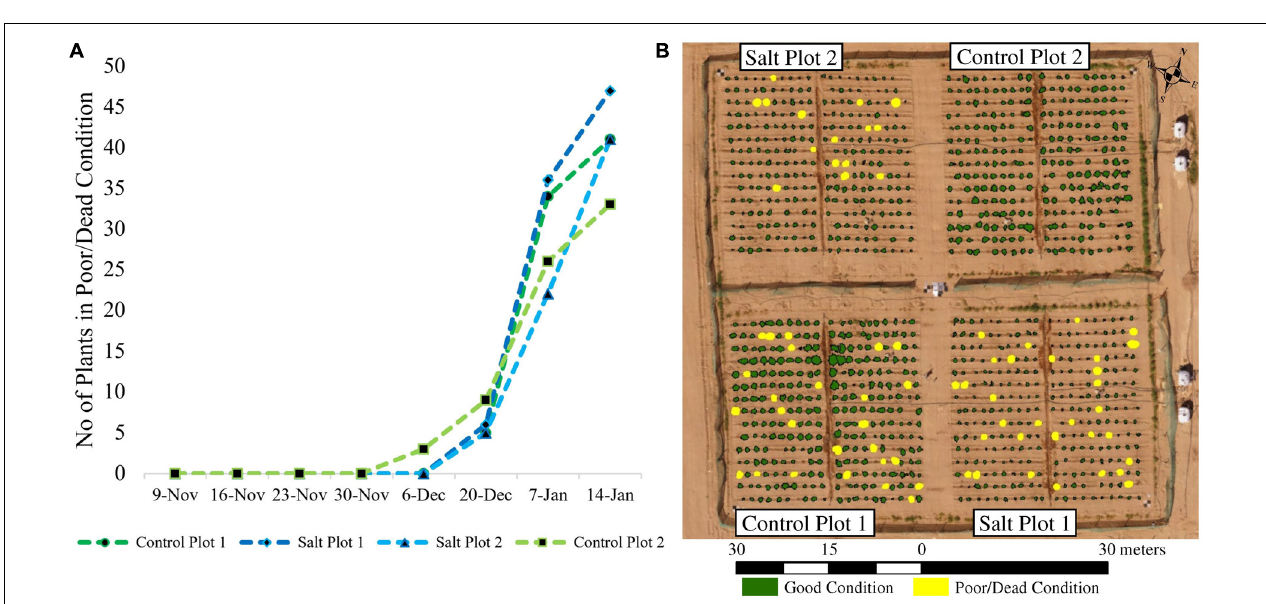
FIGURE 6 | Shifts in tomato plant location due to sandstorms occurring between December 6 and 20, 2017.